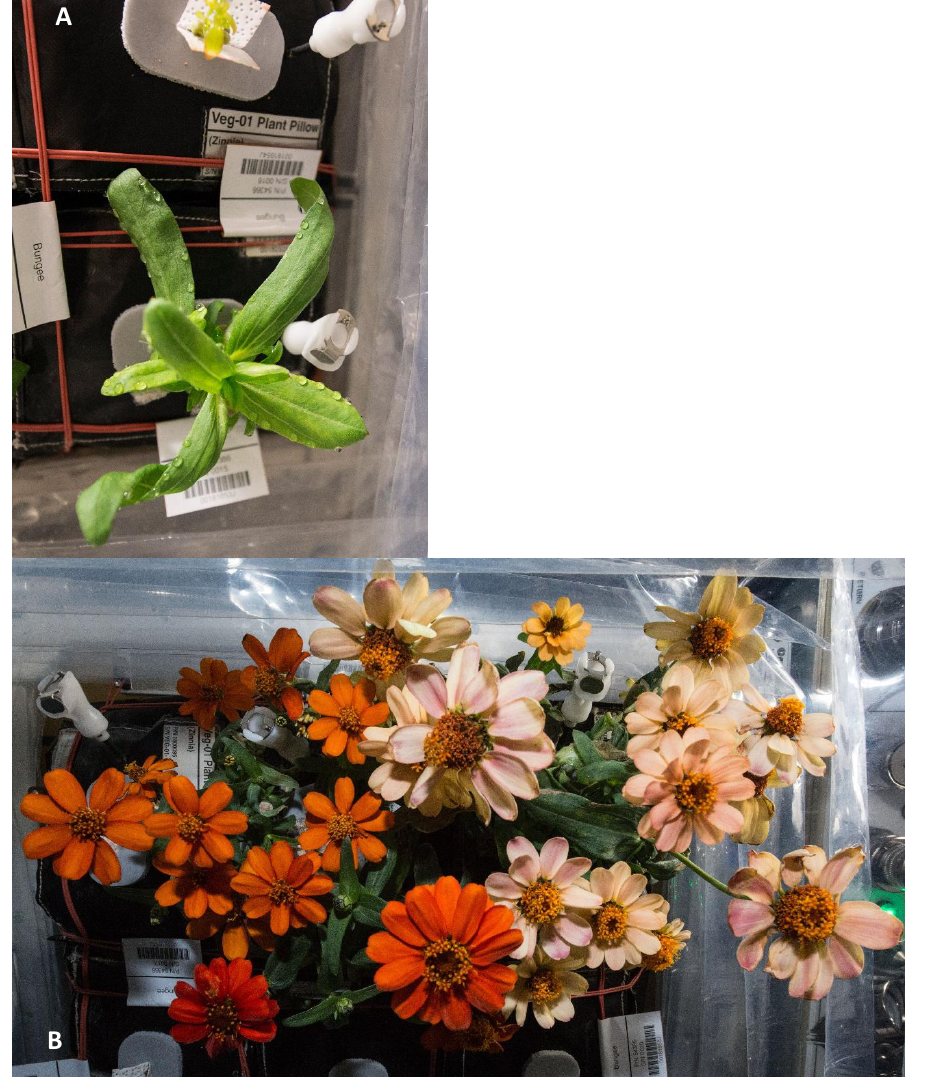
Figure 5. A Zinnia plant exhibiting guttation and leaf curling, likely due to excess water at twenty nine days after initiation. A stunted,